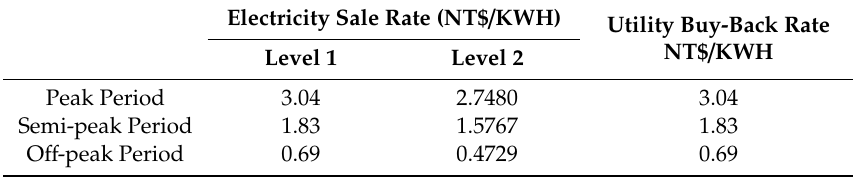
Table 1. The time-of-use rates of Taipower